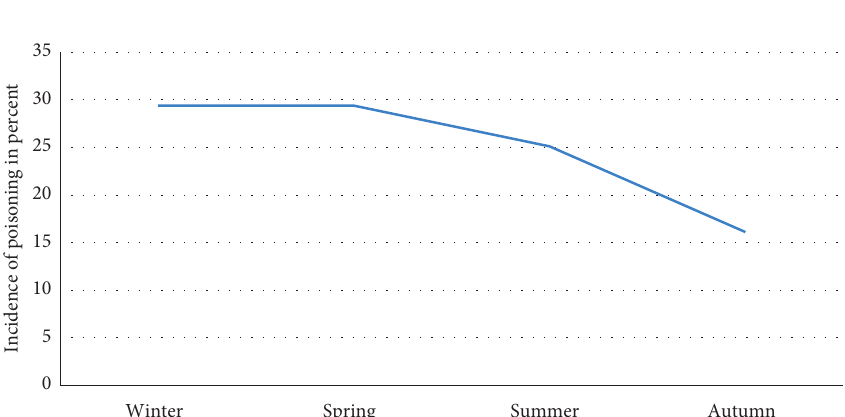
Figure 1: Seasonal patterns of poisoning in Nekemte, western Ethiopia, 2018. Key: autumn � September to November; winter � December to February; spring � March to May; summer � June to